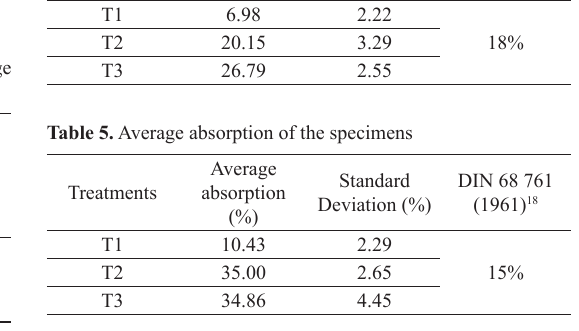
Table 4. Average swelling of the test specimens, standard deviation and value required by the standard. Treatments